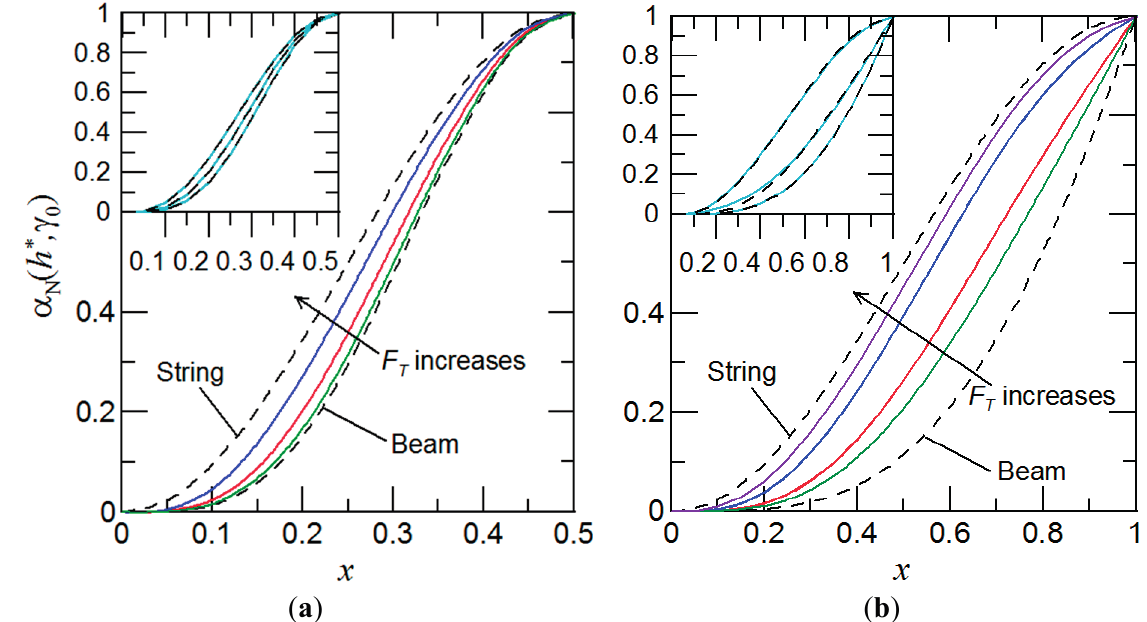
Figure 4. Variation of α N ( h * , γ 0 ) for different values of F T , where α N ( h * , γ 0 ) = α ( h * , γ 0 )/ α max ( h * , γ 0 ) and α max ( h * , γ 0 ) is the maximum value of α for ( a ) suspended and ( b ) cantilever configurations, respectively. The green color represents α N ( h * , γ 0 ) at b = 5 (for other colors the b values differ for suspended and cantilever cases). Insets present the comparison between mode shapes (dashed line), Y N ( x ) = [Y( x )/Y max ( x )] 2 , and position functions (solid line), α N ( h * , γ 0 ) = α ( h * , γ 0 )/ α max ( h * , γ 0 ), for different values of F T . Y max ( x ) stands for the maximum value of the mode